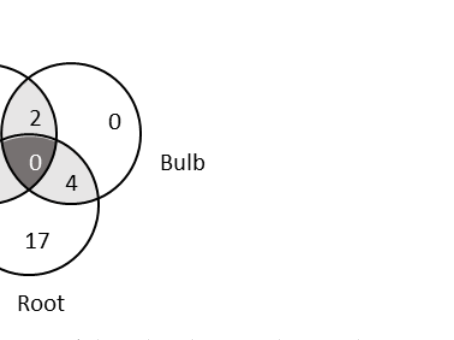
Figure 5. Venn diagram of shared and unique bacterial genera in L. aestivum ‘Gravity giant’. The isolates from the bulbs were affiliated to six genera, which were shared with either shoot (two genera) or root (four genera) parts, and no genera were unique in bulbs. In shoots, the most abundant genera were Rahnella , Variovorax and Luteibacter , while in roots, Bacillus , Paenibacillus and Steptomyces were the dominant genera (Figure 2). 3.3. Alkaloid Screening Using High-Performance Thin-Layer Chromatography (HPTLC) Analysis Endophytic bacteria extracts were investigated for their phytochemical characteristics. For this purpose, the methanolic extracts obtained from bacterial pellets were screened for their potential to produce alkaloid using Dragendorff’s reagent after the development of HPTLC plates (Figure S2). Over time after the Dragendorff spraying, some orange signals were observed. Among 69 tested strains, around 14 isolates showed some clear coloring reaction for Dragendorff’s reagent (Table 1), but none of these molecules had the same Rf value as the standard compounds of lycorine and galantamine, which are known Amaryllidaceae alkaloids produced by L. aestivum . Table 1. List of strains of which extract (possibly) reacted to Dragendorff’s reagent.